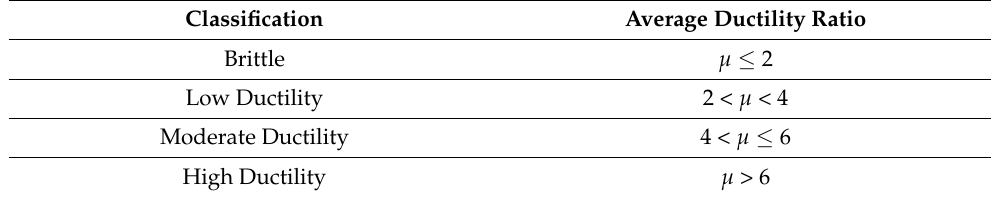
Table 1. Proposed ductility classes for connections or components (Adapted from Ref.